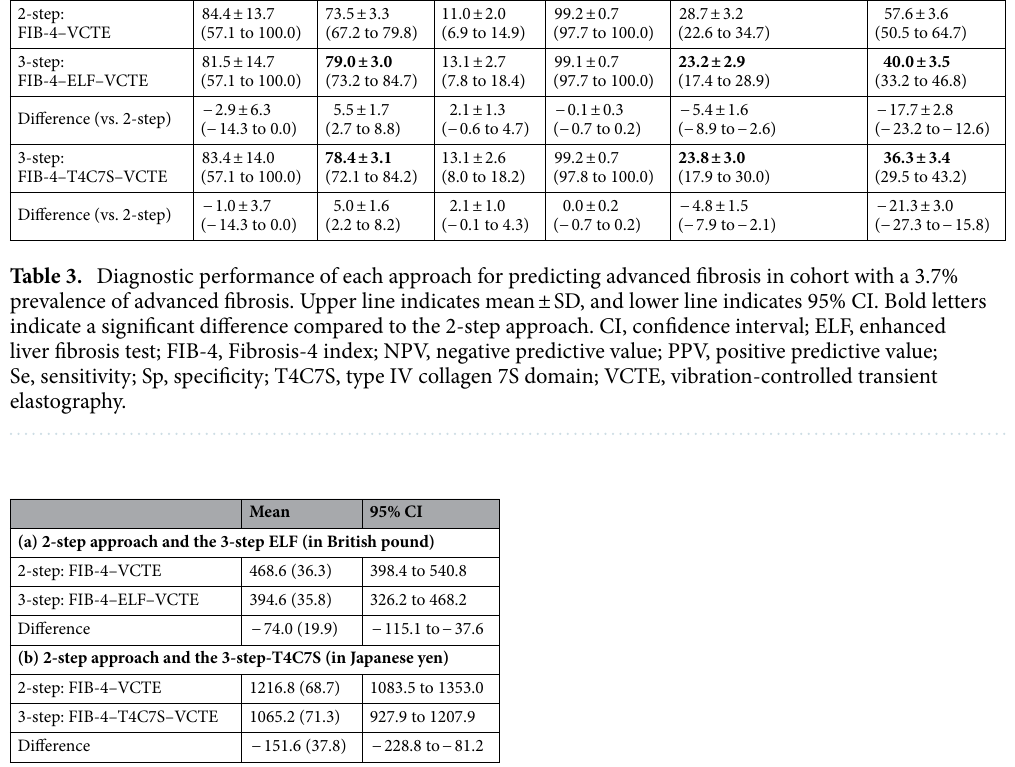
Table 4. Mean total cost per person at 3.7% prevalence of advanced fibrosis. Data are means (SD) except for 95% CI. Units are in (a) British pound and (b) Japanese yen. CI, confidence interval; ELF, enhanced liver fibrosis test; FIB-4, Fibrosis-4 index; T4C7S, type IV collagen 7S domain; VCTE, vibration-controlled transient